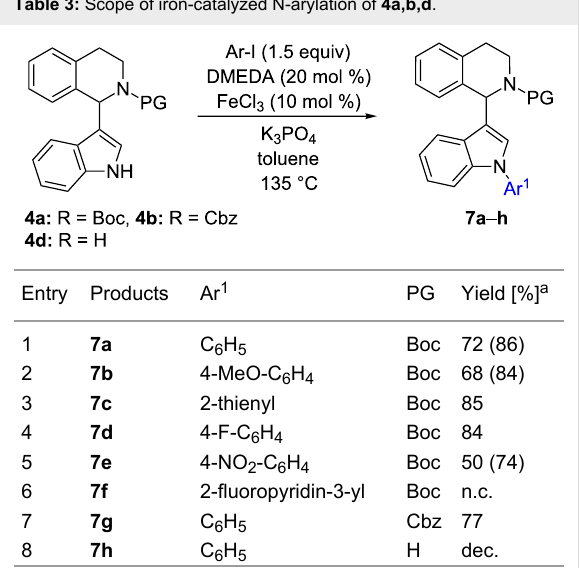
Table 3: Scope of iron-catalyzed N-arylation of 4a,b,d